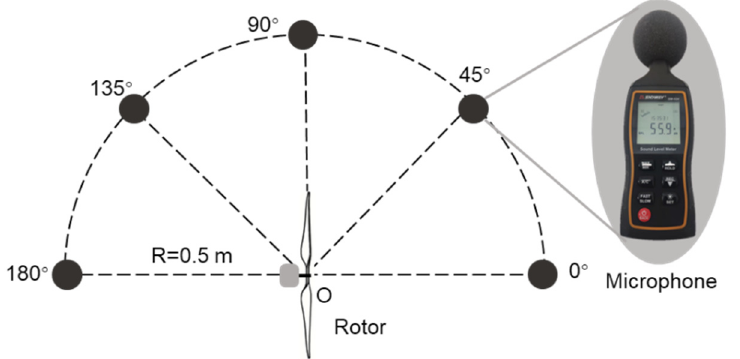
Figure 7. Schematic illustration of semicircular microphone array for acoustic performance test. Table 5. The average background noise of different motor speeds in the open space.